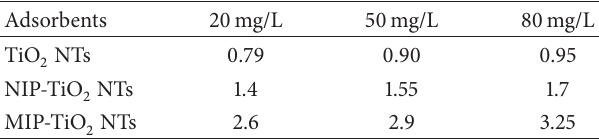
Table 1: Percentage of PFOA adsorption for different adsorbents at various initial concentrations (%).